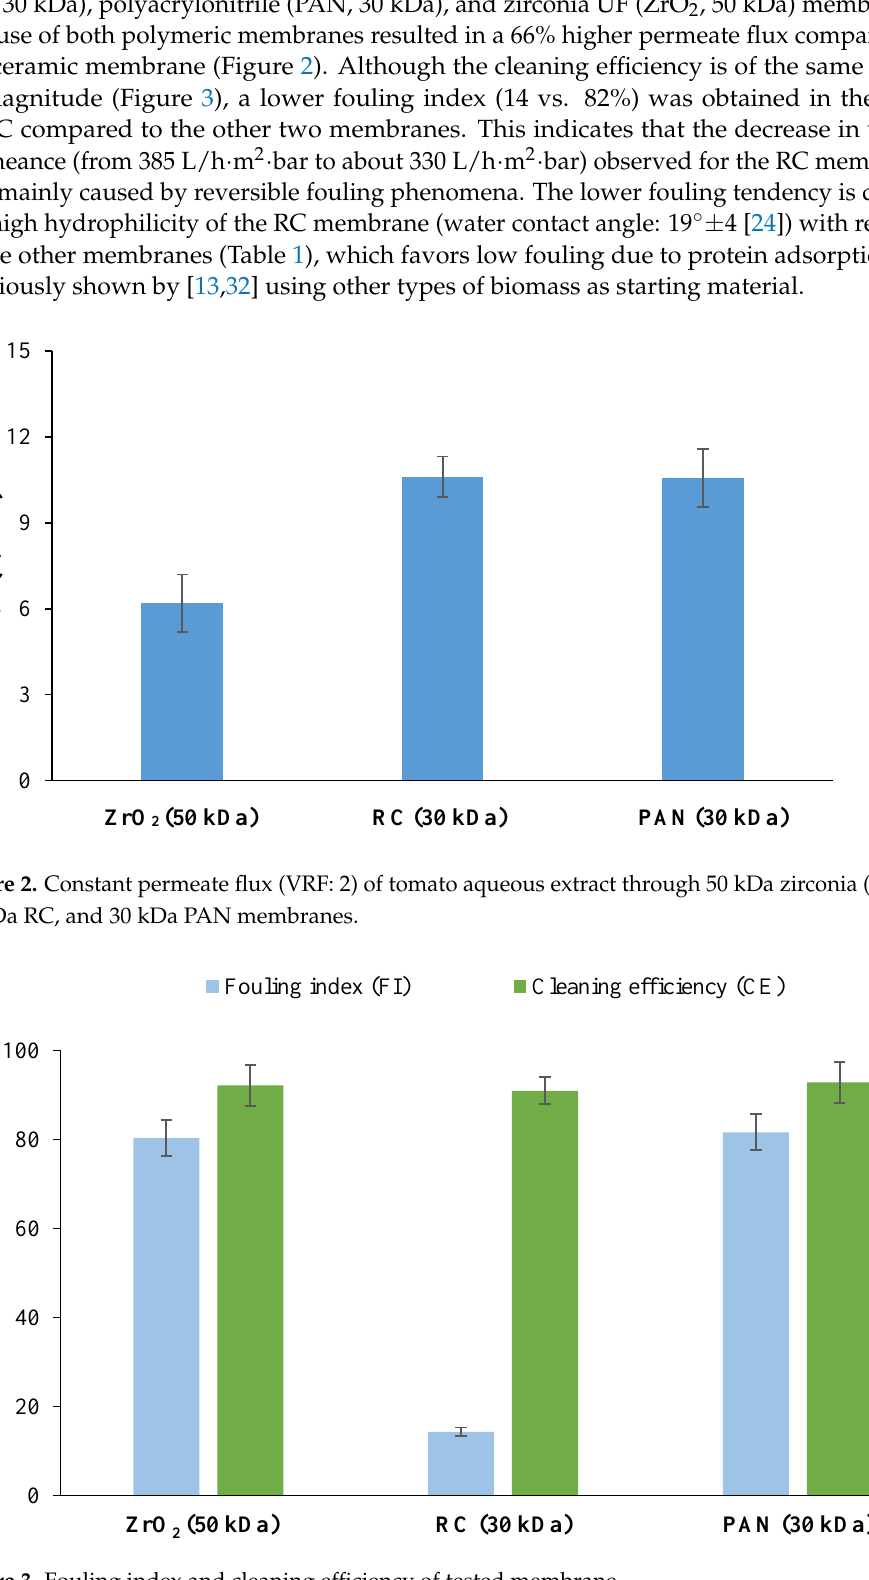
Figure 3. Fouling index and cleaning efficiency of tested membrane.